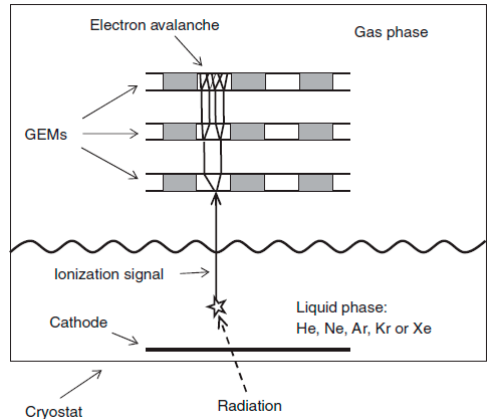
Figure 2. Basic concept of charge signal amplification in two-phase detectors, using gas electron multiplier (GEM)-like structures [4].